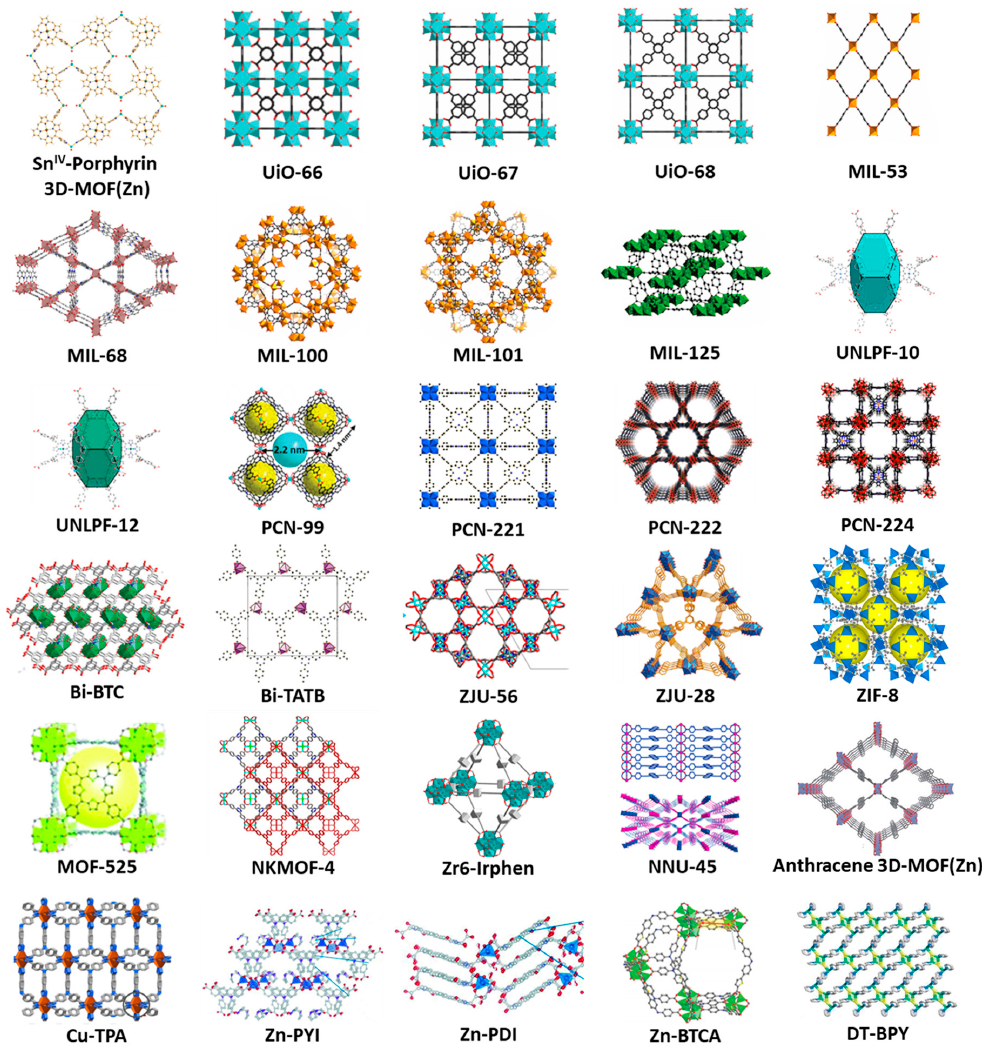
Figure 4. Structural motifs of MOFs applied into photocatalytic organic transformations. Adapted